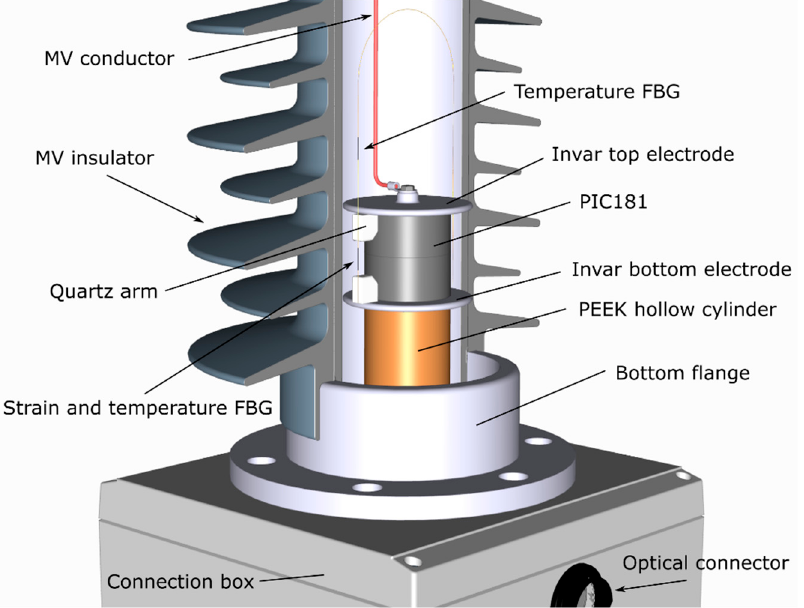
Figure 1. Construction of the first prototype photonic voltage transducer for medium voltage (MV) networks.